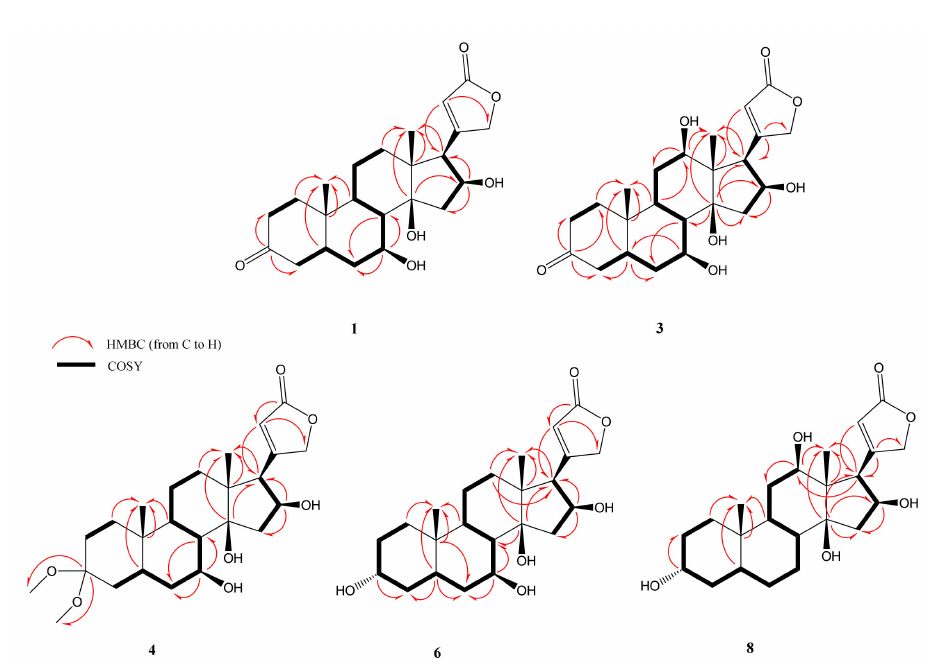
Figure 3. Key HMBC and COSY correlations of the new metabolites (compounds 1 , 3 , 4 , 6 and 8 ) obtained from the microbial biotransformation of gitoxigenin by A. eureka 1E1BL1. The molecular formula of 2 was determined as C 23 H 32 O 5 based on the HR-ESI-MS analysis ( m / z 433.2227 [M + FA-H] − , calcd. 433.2231 for C 23 H 32 O 5 ) with eight indices